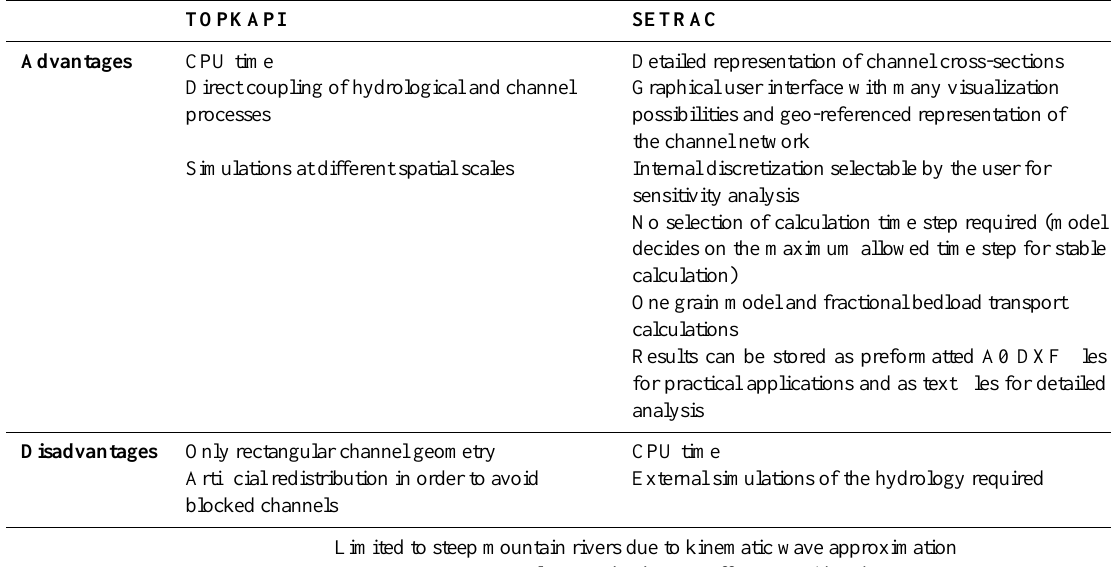
Table 2. Advantages and disadvantages of TOPKAPI and